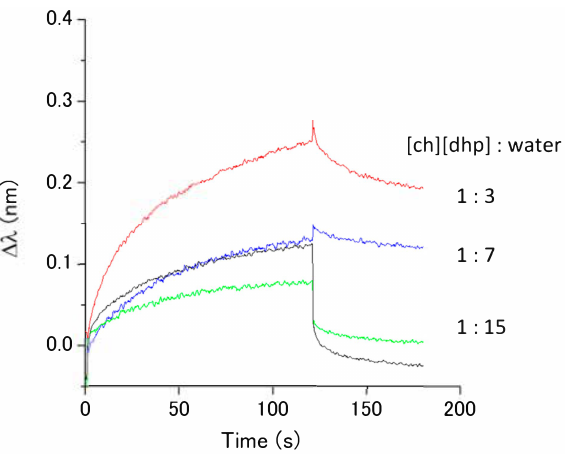
Figure 3. Mannose binding ability of lyophilized ConA dissolved in buffer (black), and ConA treated in hydrated [ch][dhp] mixed with 3 (red), 7 (blue), and 15 (green) water molecules per ion